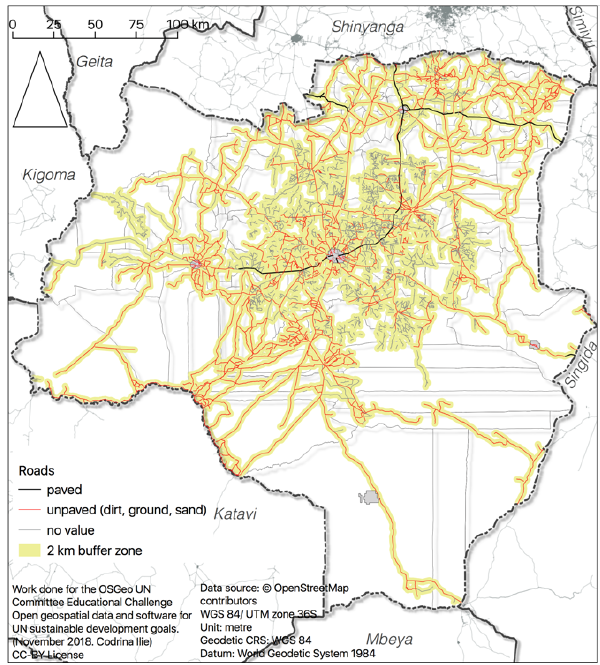
Figure 3. Roads in good condition in Tabora region of Tanzania